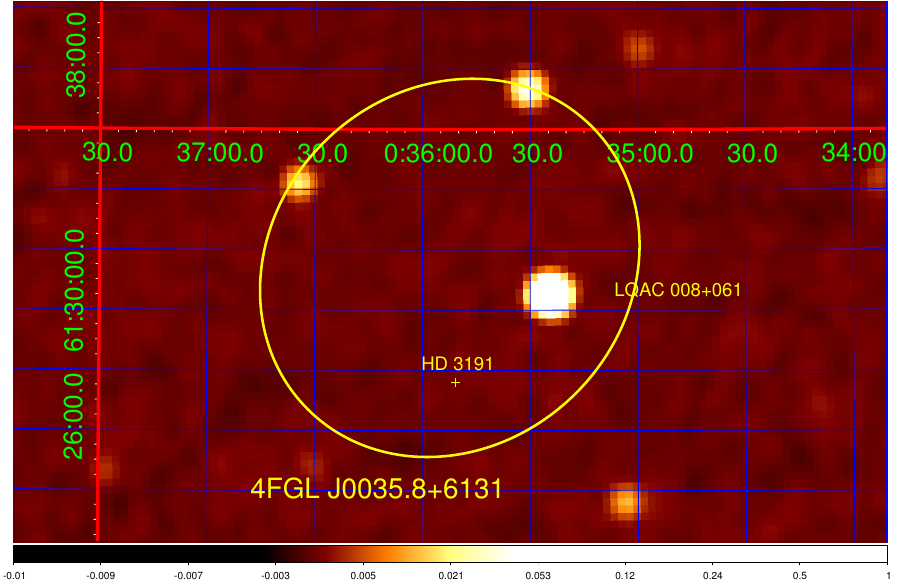
Figure 2. View of the 95% confidence ellipse of Fermi source 4FGL J0035.8+6131 plotted against the NRAO VLA Sky Survey image at the 20 cm wavelengths [27]. The brightest radio source is LQAC 008+061, which has been proposed as a blazar counterpart candidate. The small cross marks the HD 3191 location, which is also consistent with the Fermi ellipse. Red axes display J2000.0 equatorial coordinates and the horizontal scale indicates the radio brightness scale in Jy beam − 1